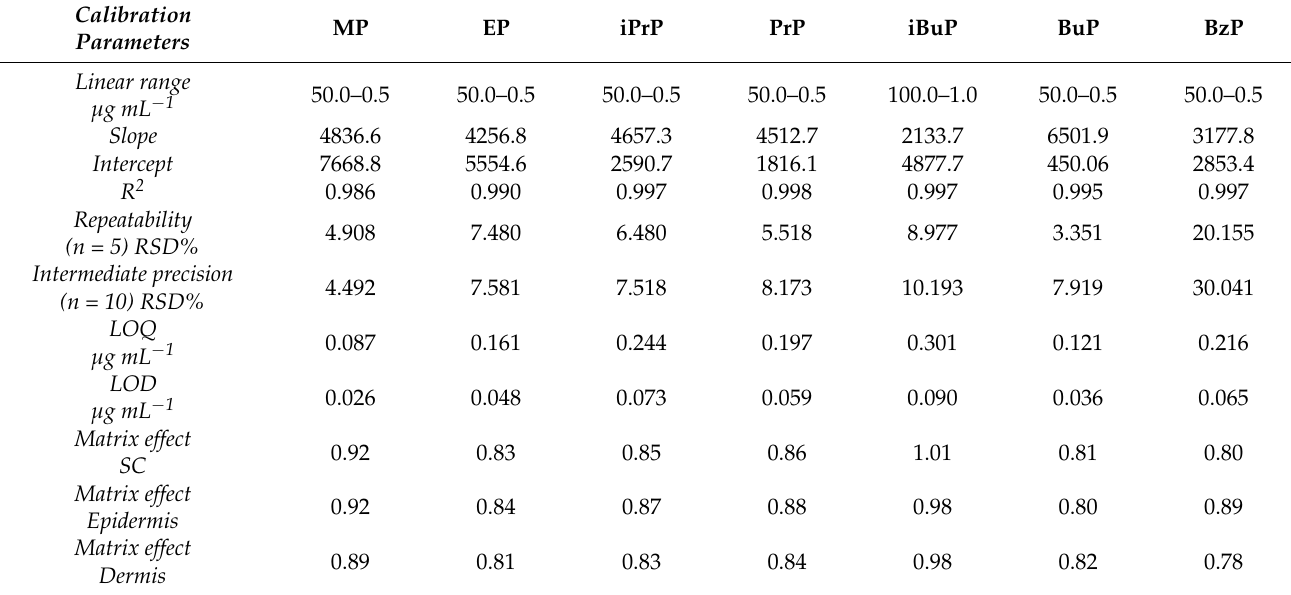
Table 1. Summary of method validation parameter